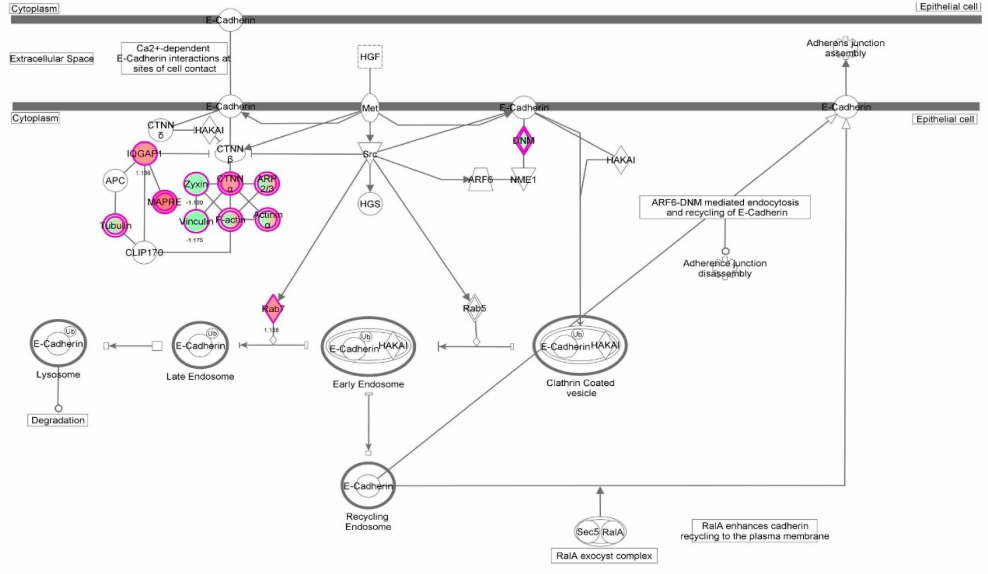
Figure 34. Remodeling of epithelial adherent junction signaling pathway was regulated by vancomycin in HK-2 cells. HK-2 cells were treated with 50 µ g/mL vancomycin for 24 h and the protein samples were subject to quantitative proteomic analysis. Red indicates an up-regulation; green indicates a down-regulation. The intensity of green and red colors indicates the degree of down- or up-regulation. Solid arrow indicates direct